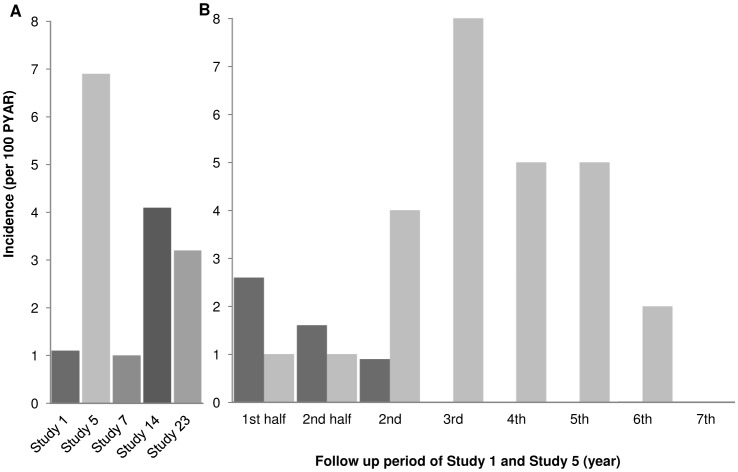
Incidence of ENL reported per person years at risk.(A) Incidence for studies reporting incidence per 100 PYAR. (B) Incidence over time during different study periods for a Bangladesh [43] and Ethiopian [41] study.